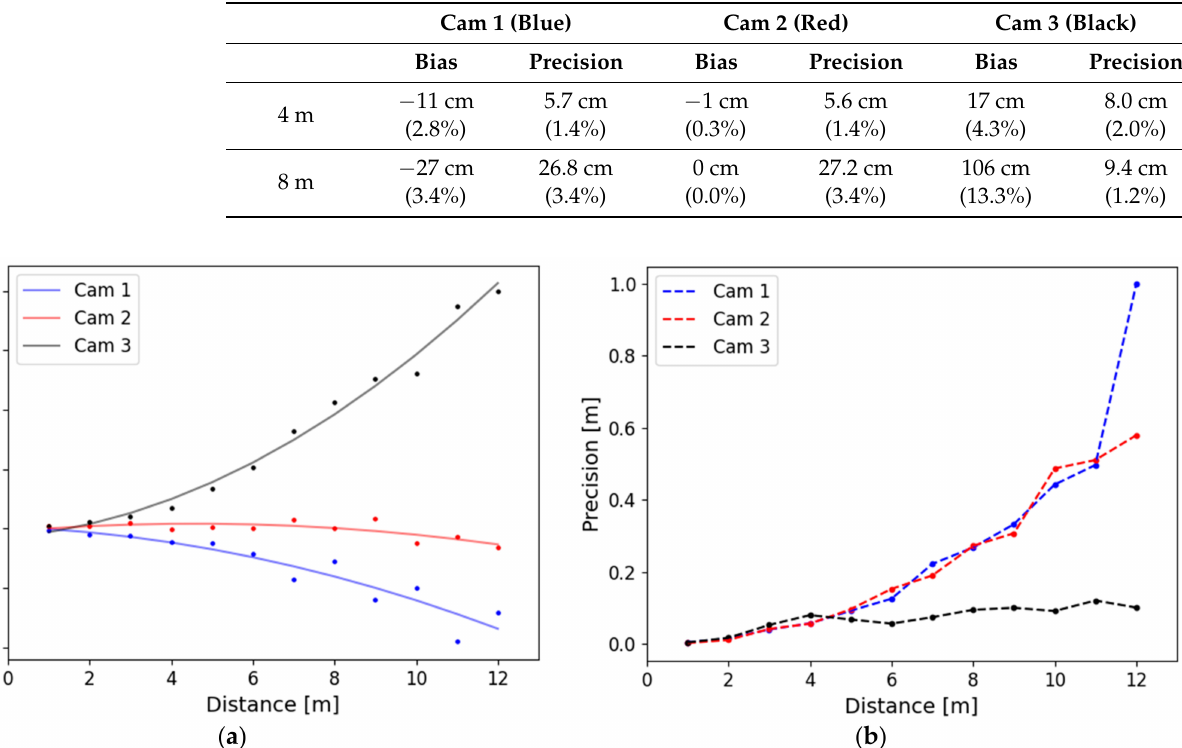
Table 3. Bias and precision values of depth measurements at 4 m and 8 m with three different RealsSense D455 units with respective colors as shown in Figure 12. Percentage values show the respective metric bias and precision values in relation to the respective range.